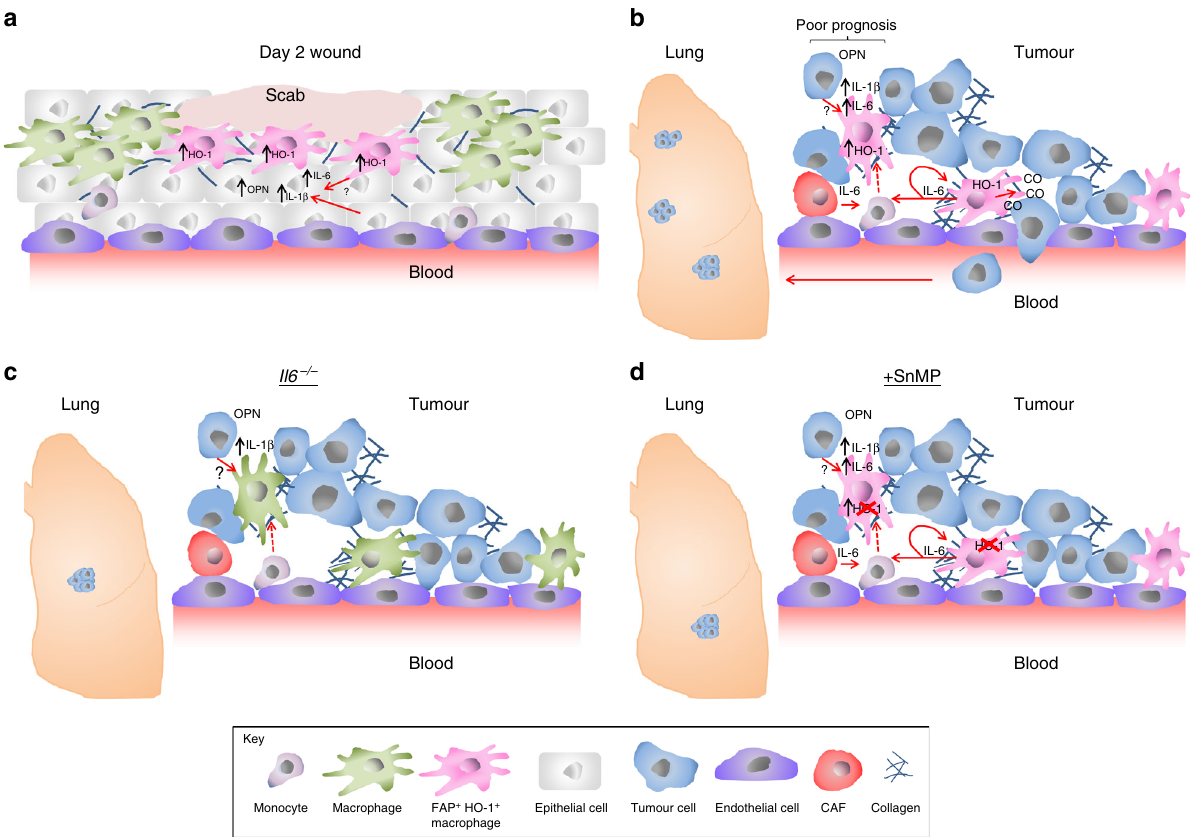
Fig. 7 Macrophages are exploited from an innate wounding response to facilitate metastasis. a The acute wounding in fl ammatory response results in a microenvironment with high levels of osteopontin (OPN), IL-1 β and IL-6. In response to IL-6, in combination with the collagen-rich environment of the skin, the macrophages adopt an FAP + HO-1 + wound response phenotype. b Tumours exploit the acute wound healing response of macrophages, by inducing